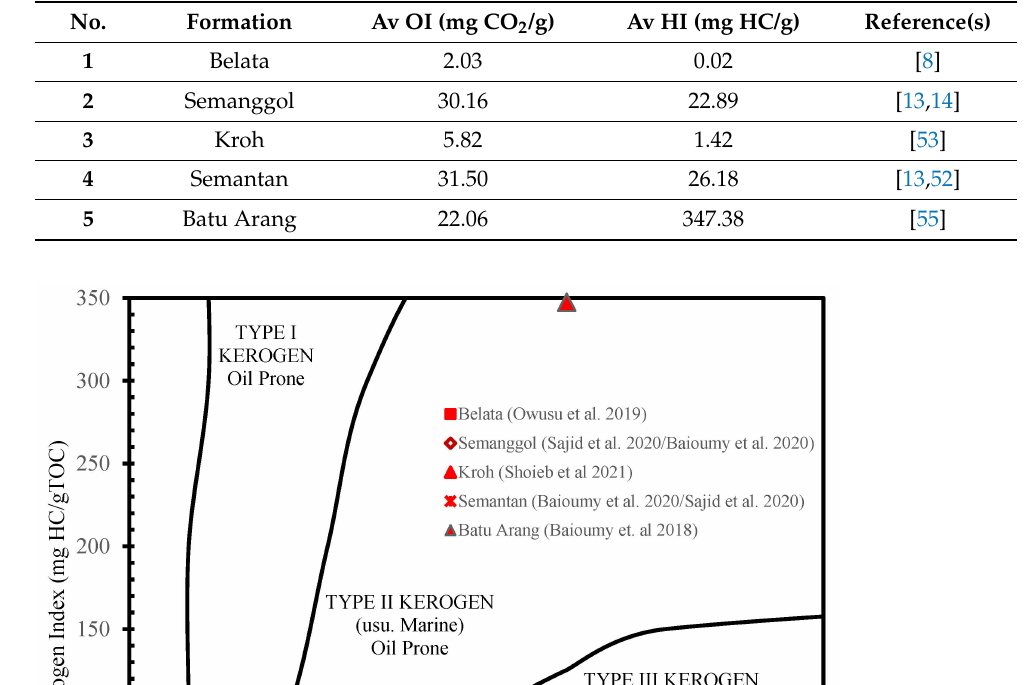
Table 3. Average OI and HI values of formations in PM.